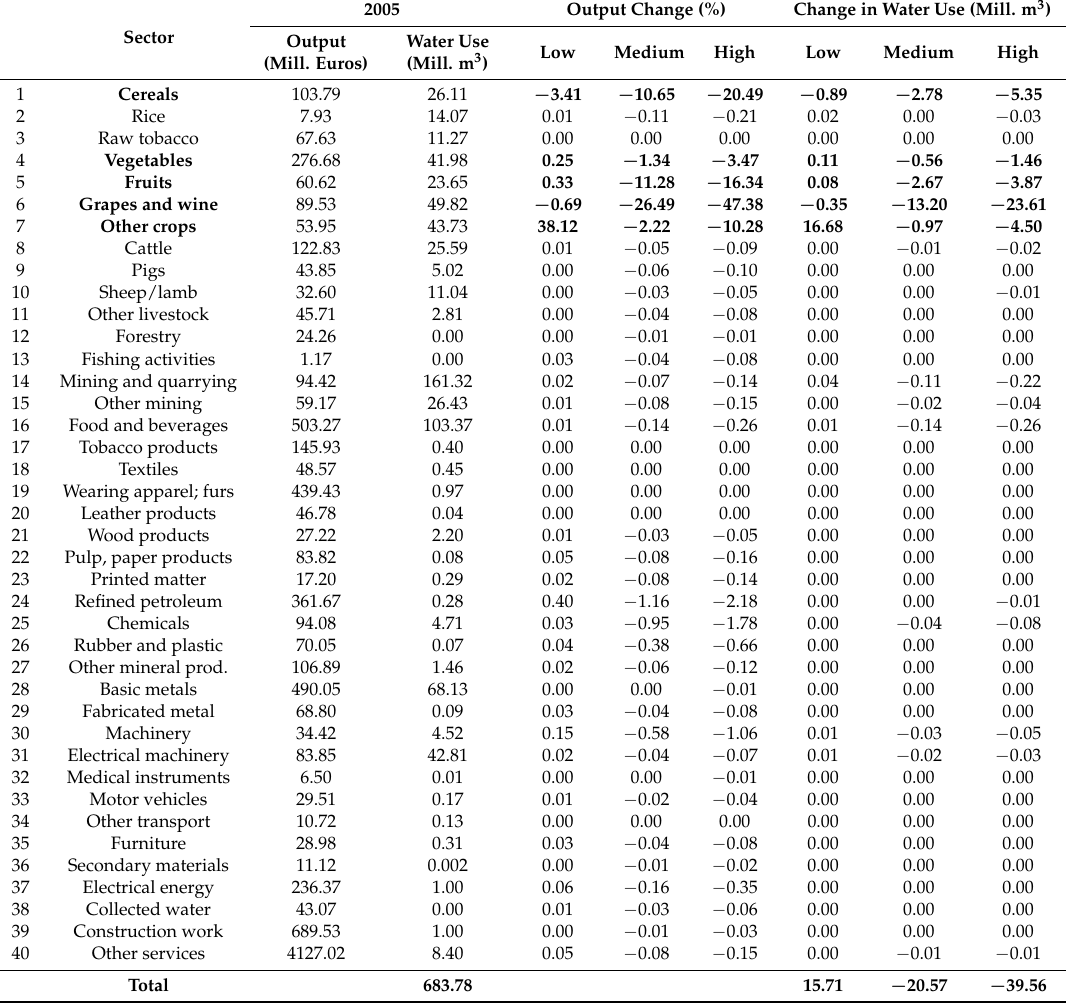
Table 5. Changes in output and water use of agriculture and other sectors due to different climate change